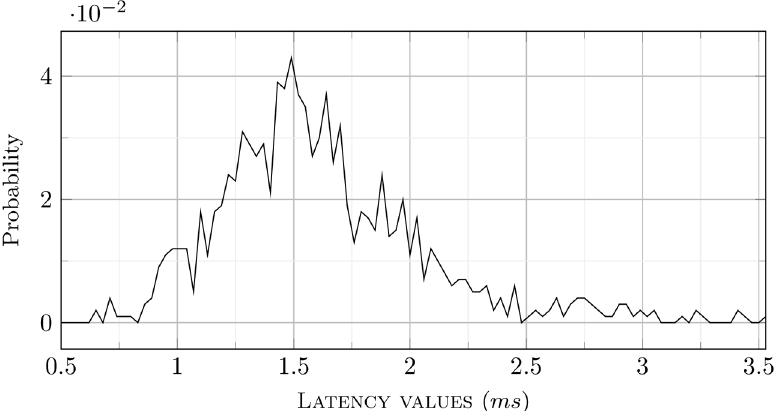
Figure 19. Latency values for the seventeenth series of 1000 requests/responses.